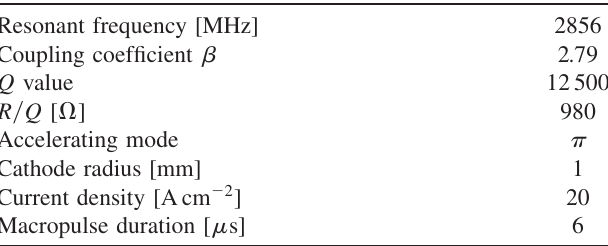
TABLE II. Parameters of KU-FEL thermionic rf gun used in the simulation.